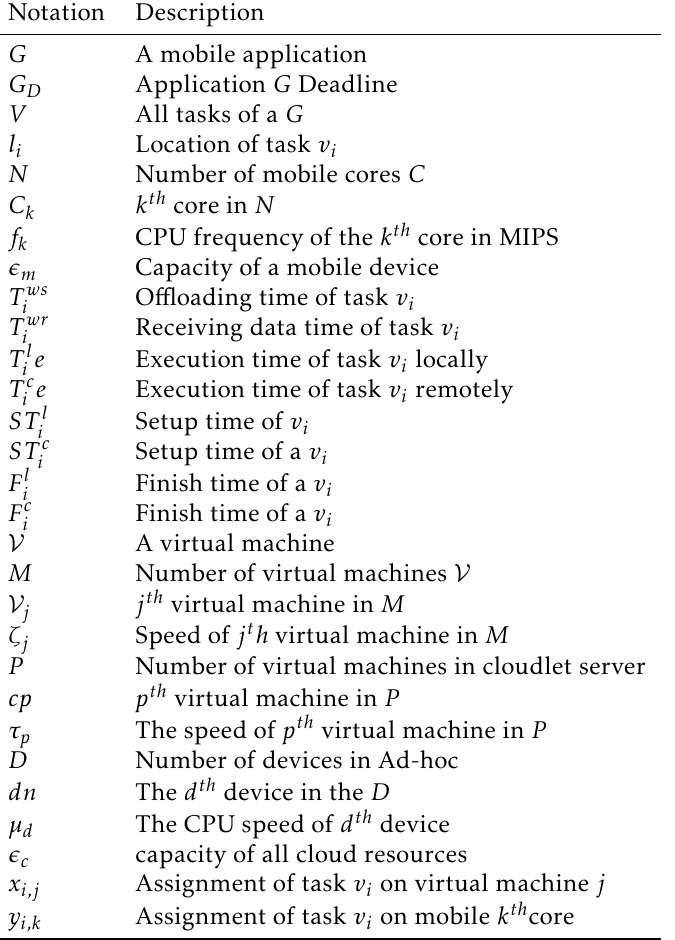
Table 1. Mathematical